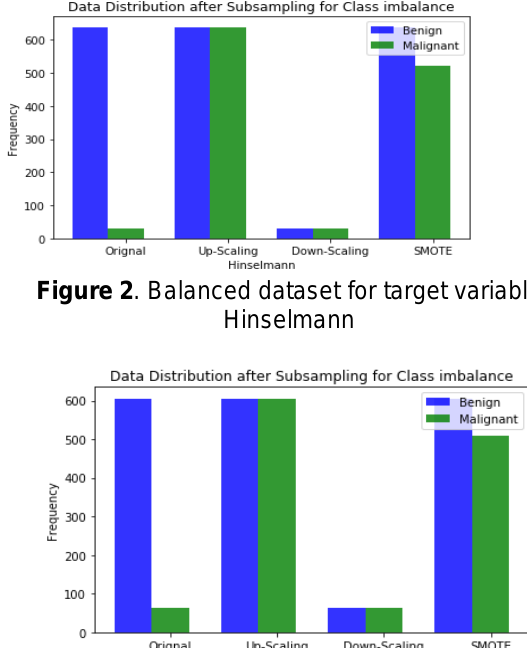
Figure 5 . Balanced dataset for target variable